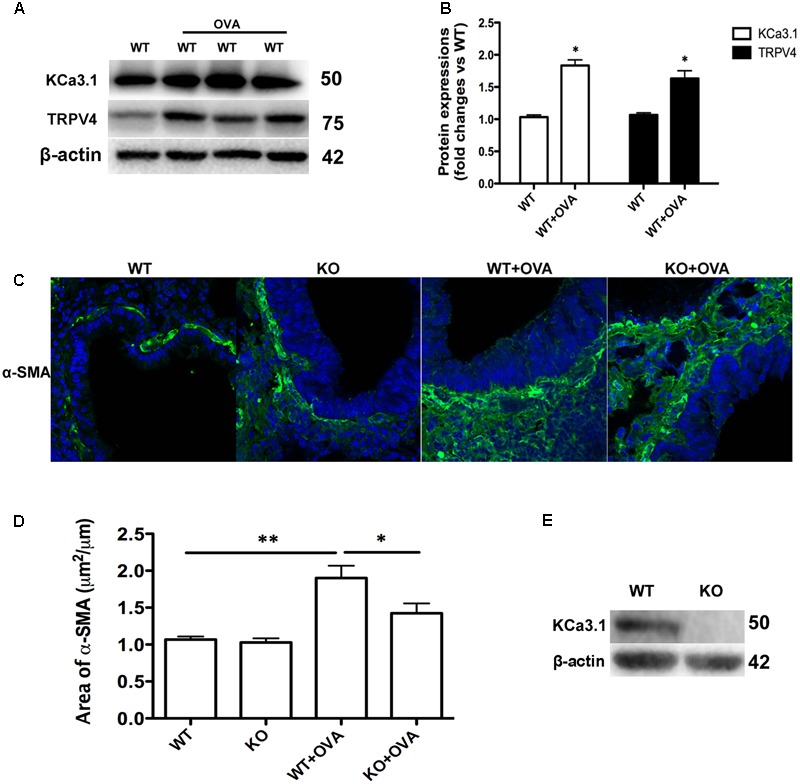
Gene deletion of KCa3.1 prevented OVA-induced up-regulation of α-SMA. (A) The KCa3.1 and TRPV4 proteins expressions in the lung sections from WT and WT + OVA groups mice. (B) Data were presented as means ± SEM (n = 5). ∗p < 0.05, unpaired, two-tailed Student’s t-test compared with WT mice. (C) Representative photomicrographs of immunofluorescence reactivity of lung sections from WT, KO, WT + OVA, and KO + OVA groups mice using antibody against α-SMA (original magnification, x 40). (D) Plot of means ± SEM measurements of the area α-SMA+ staining per μm length of bronchi basement membrane. n = 4, ∗p < 0.05, ∗∗p < 0.01, Kruskal–Wallis test followed by Dunn’s multiple comparison test compared with WT + OVA mice. (E) Western blot showing the absence of KCa3.1 expression in the lung tissues of KCa3.1 KO mice. WT, wildtype; KO, knockout.